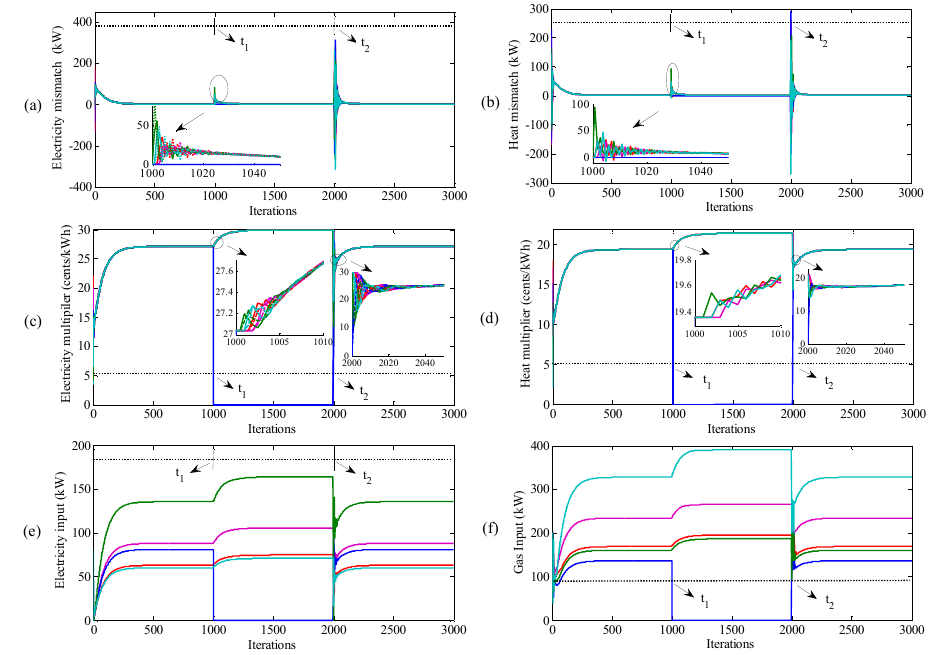
Figure 6. Plug and play capability: ( a ) the electricity mismatch; ( b ) the heat mismatch; ( c ) the electricity multiplier; ( d ) the heat multiplier; ( e ) electricity input; ( f ) gas input.